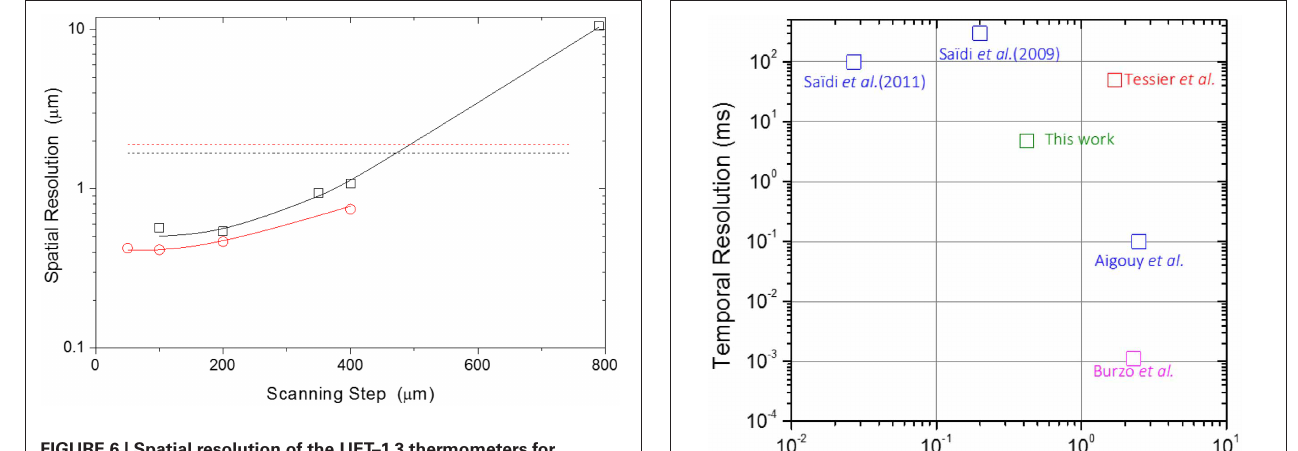
temperature with spatio-temporal resolution of 0.42 μ m/4.8